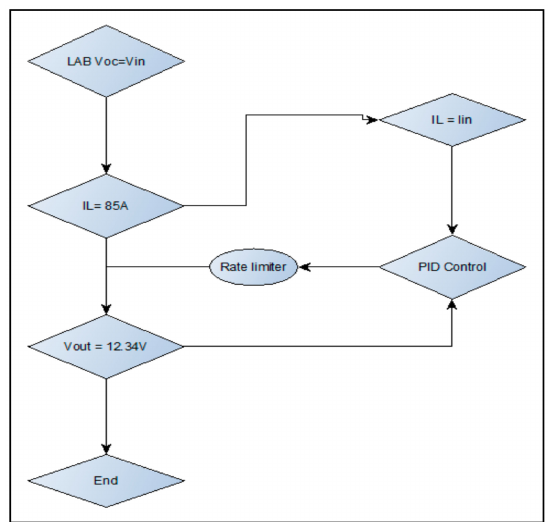
Figure 2. Boost DC/DC converter for the LAB and control strategy. PID—proportional-plus-derivative- plus-integral.